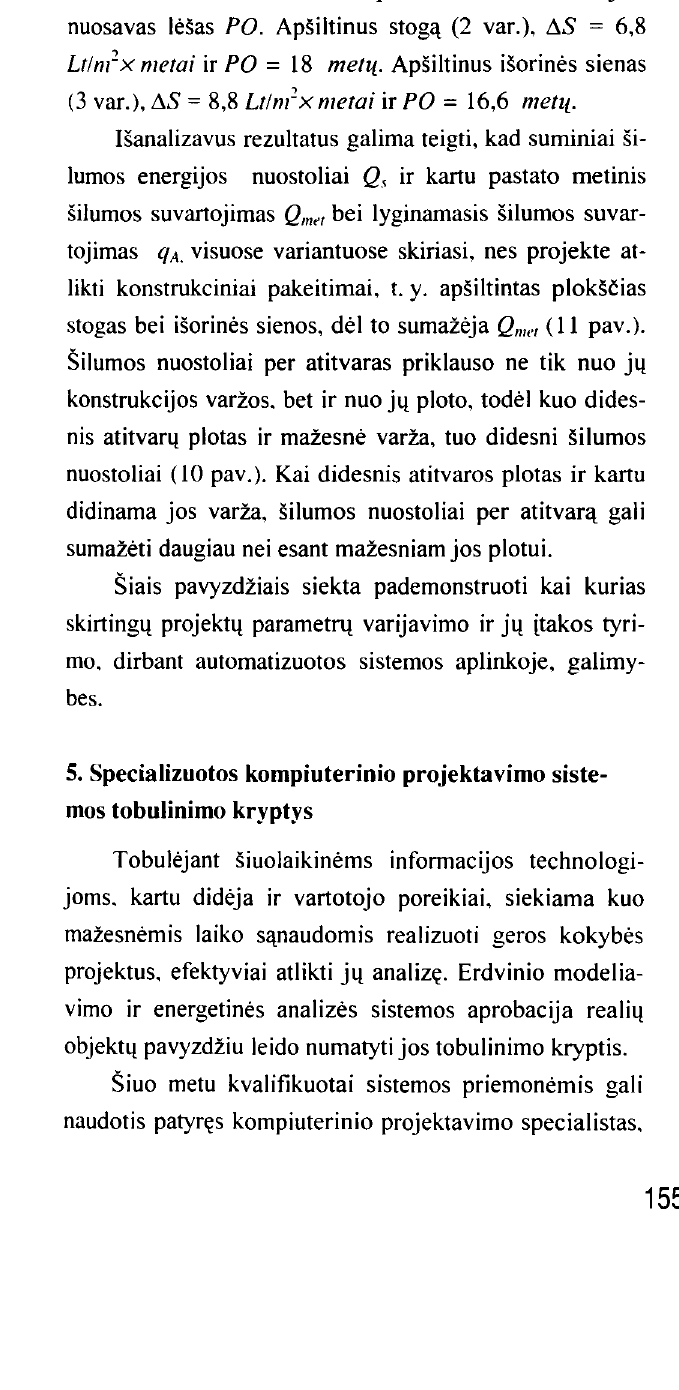
Fig 11. Comparison of indices Q.,, Qmer and qA of variants of the building model under